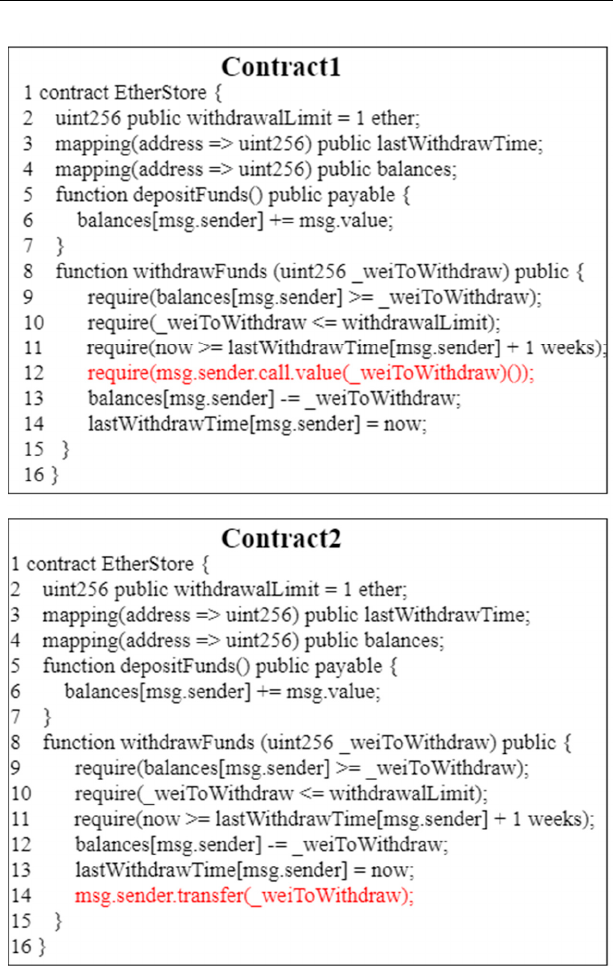
Figure 7. Similar smart contracts.